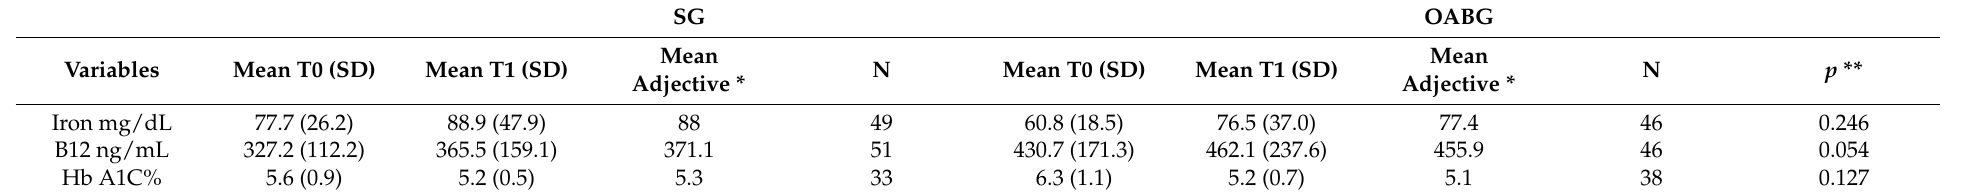
Table 5. Parameters with unequal variables analyzed by ANCOVA at T1 time